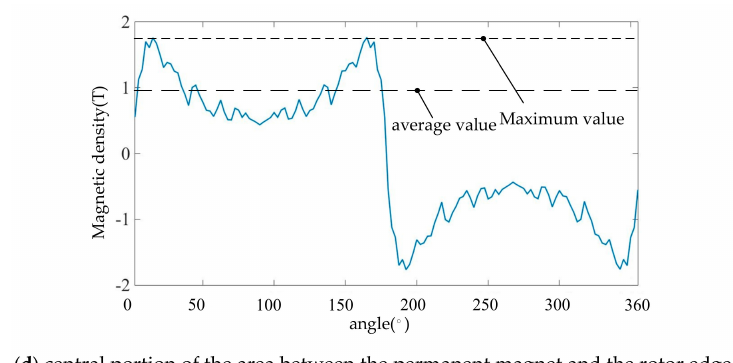
Figure 5. Magnetic flux density in each region of the motor during no-load operation.